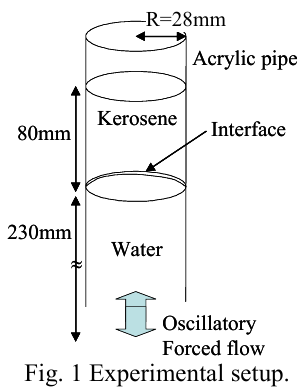
Fig. 1 Experimental